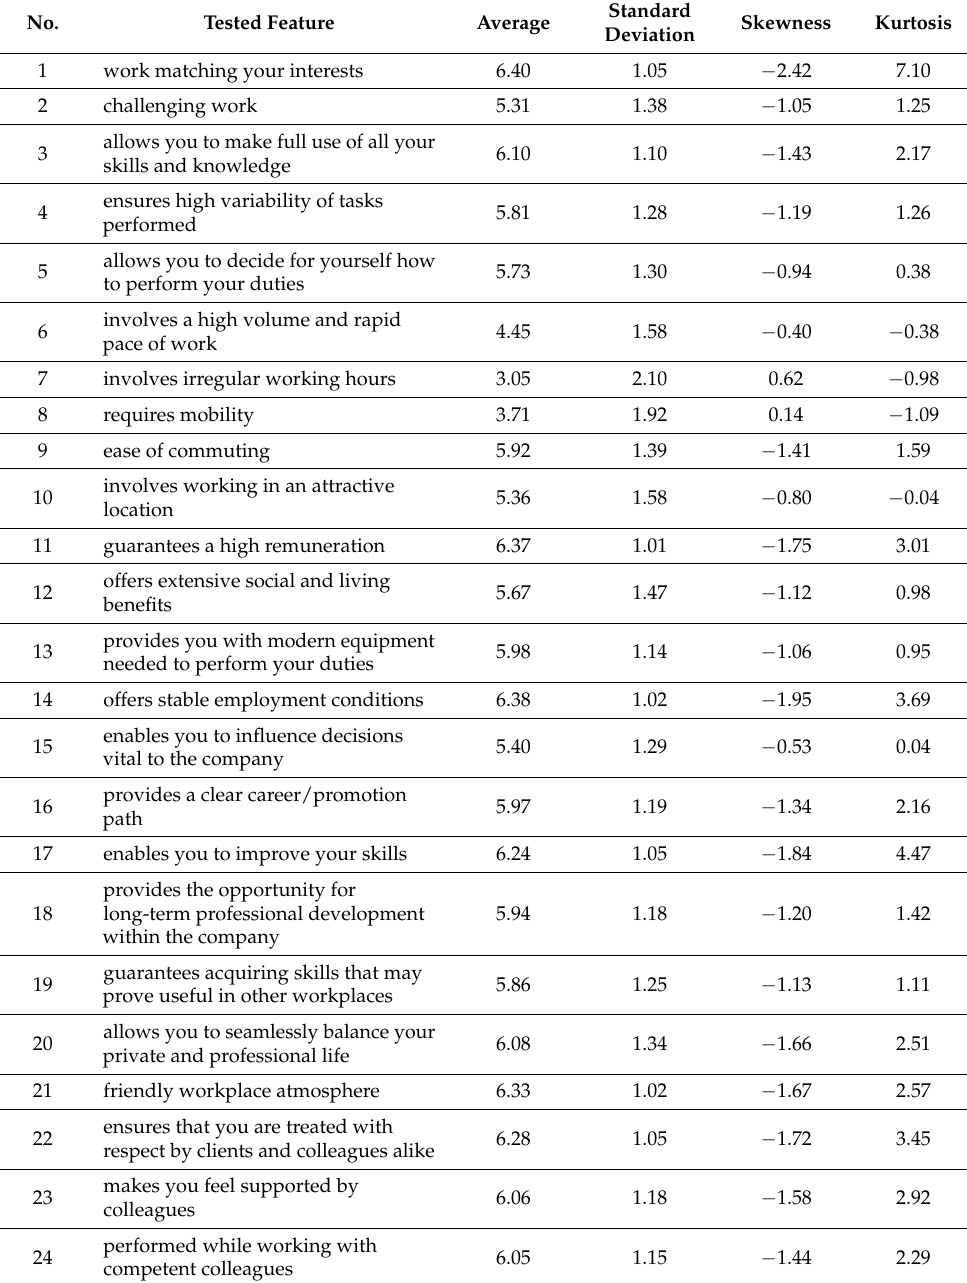
Table 2. Perceptions regarding the image of an ideal